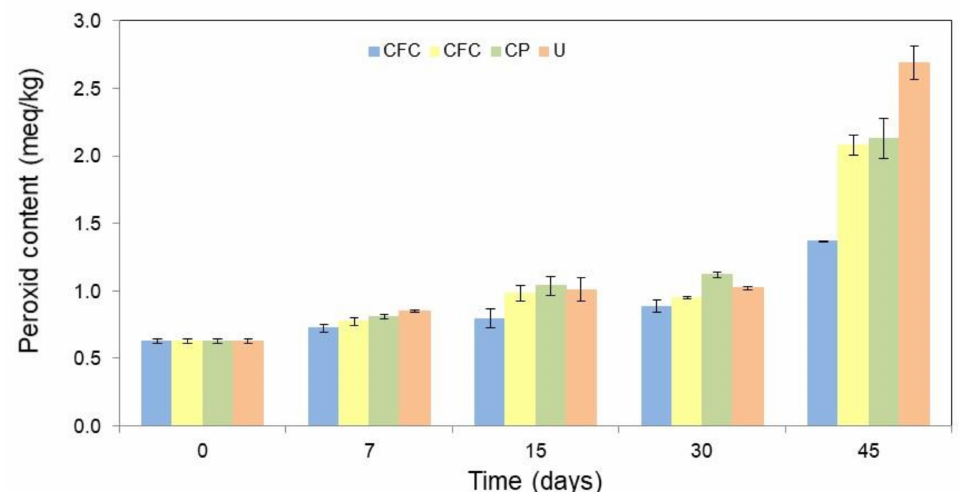
Figure 4. Peroxide content (PC, meq / kg) in the butter as a function of the packaging film used, such as: cassava starch-based films with colorant additives (CFC), cassava starch-based films without colorant additives (CF), conventional plastic (CP), and unpackaged butter (U), during di ff erent periods of time (0, 7, 15, 30, and 45 days) in storage. The error bars represent 95% confidence levels for the